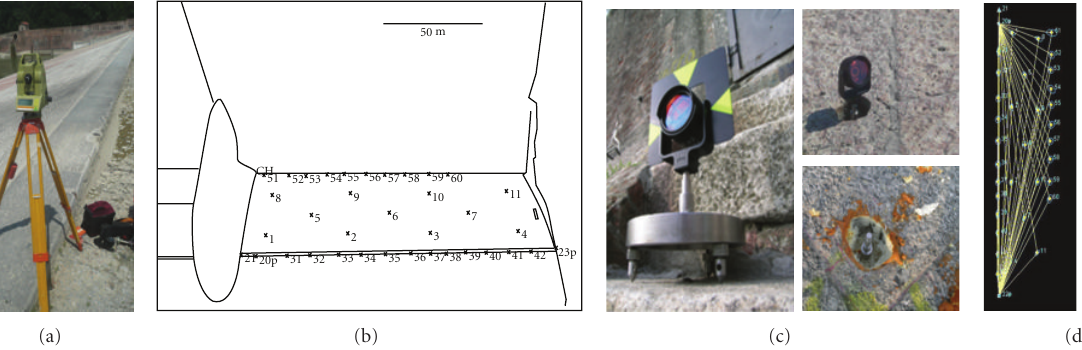
Figure 4: Classical topographic surveying :(a) total station; (b) scheme of control points distribution; (c) examples of GCPs characterised by forced centering devices (outside the structure and on the slide, resp.) measured using prisms; (d) map of the 3D adjusted network.